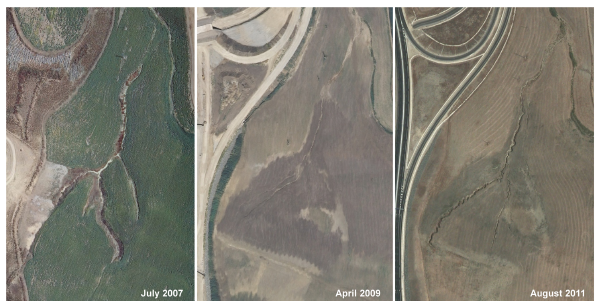
Figure 8. Views of the gully network in the 2007, 2009 and 2011 orthophotos (Junta de Andalucía, 2015). Most probably, the gully was landfilled in the summer of 2008 and, since then, there is no evidence of having been filled